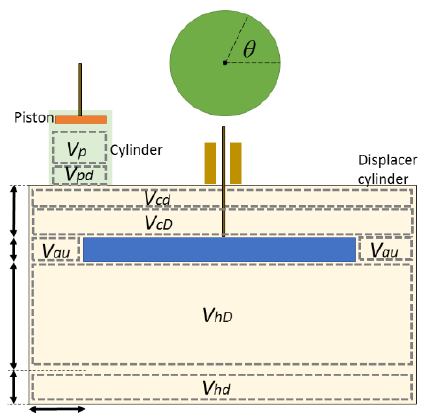
Figure 3. Volumes in thermal flow of the gamma-type Stirling engine.